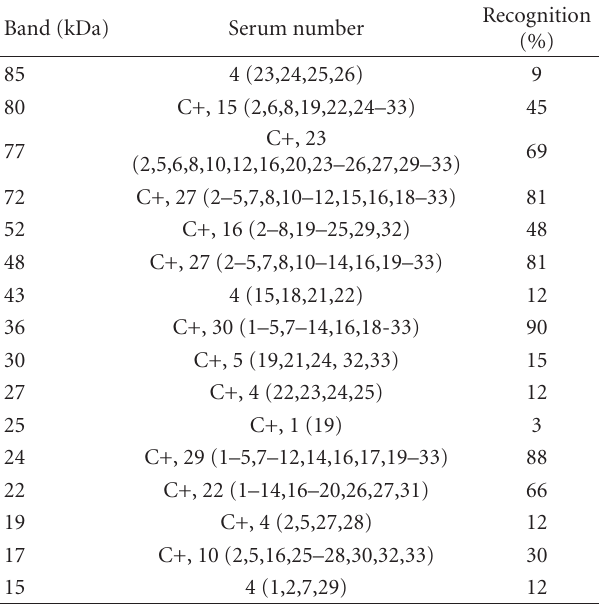
Figure 2: Western blot with tapeworm E/S Ag of Taenia solium was incubated with hamster sera infected with T. solium tapeworms (1–33). Preimmune (lane − ) and hyperimmune hamster sera antitapeworm E/S Ag of T. solium (lane +) were used as negative and positive controls. Peroxidase-conjugated antihamster IgG antibody was used as second antibody. Table 2: Recognition percentage of the di ff erent bands in tapeworm E/S Ag of Taenia solium by 33 hamster sera infected with T. solium tapeworms.